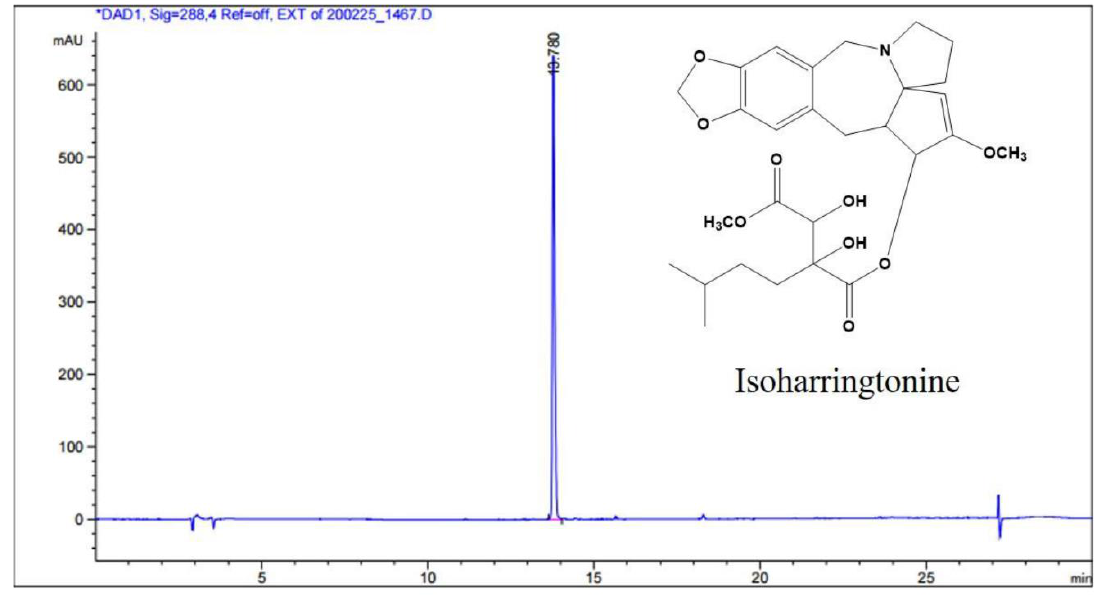
Scheme 1. High performance liquid chromatography (HPLC) chromatogram and chemical structure of isoharringtonine from Cephalotaxus koreana